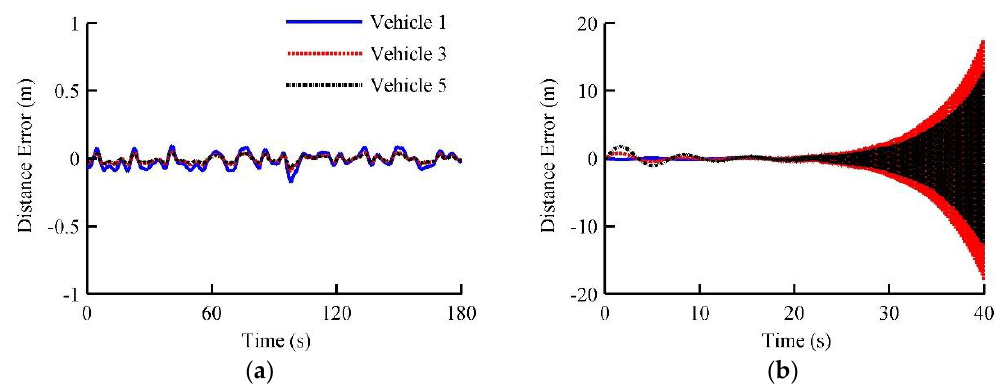
Figure 8. Stability performance of platoon interacted by PF. ( a ) Method 1 (Maximum delay is 0.1 s ). ( b ) Method 2 (Maximum delay is 0.1 s ).